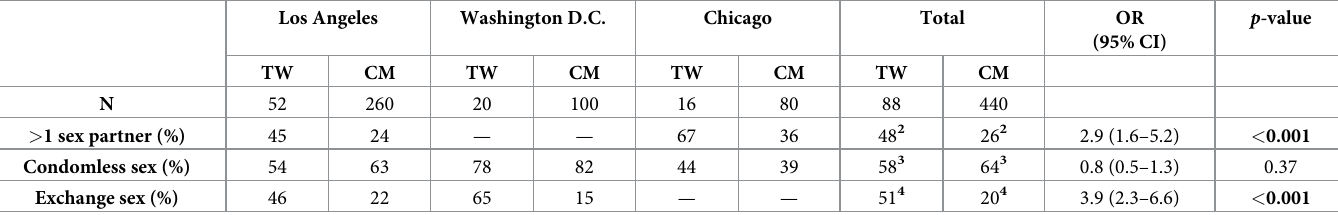
Table 4. HIV risk behaviors during reference period 1 , comparing transgender women and cisgender